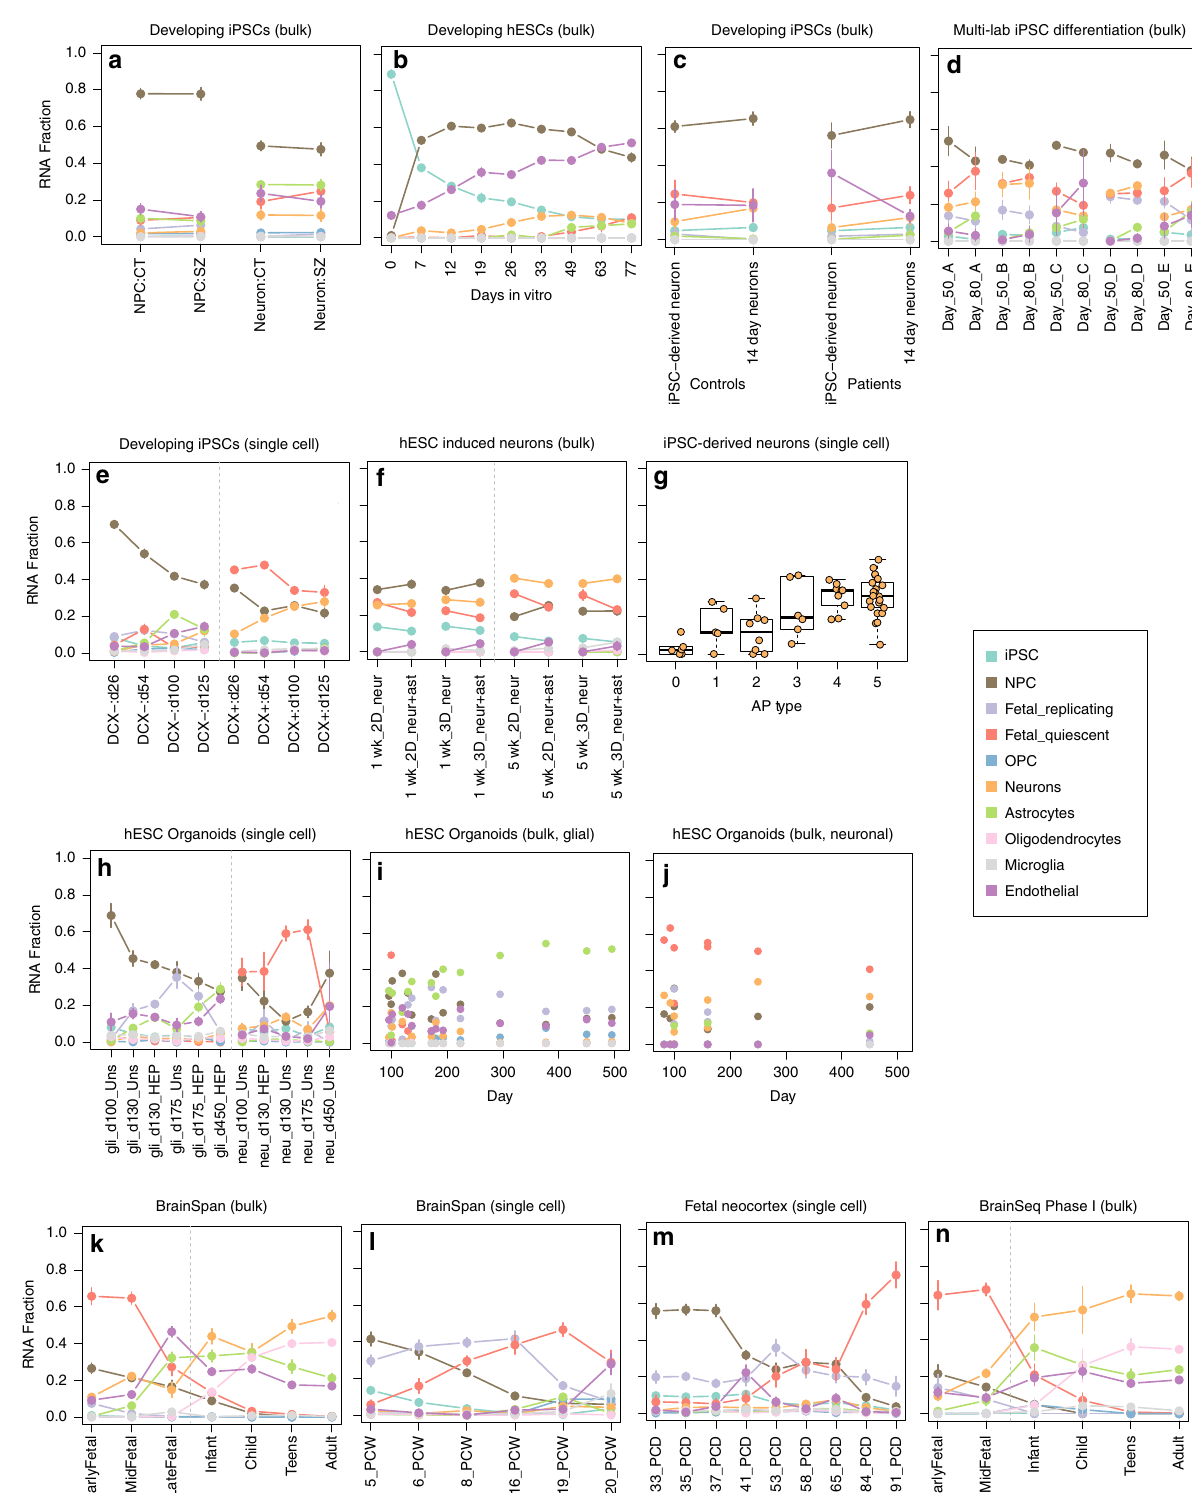
Fig. 6 Deconvoluting RNA fractions from publicly available RNA-seq data. We assessed the robustness of our deconvolution algorithm by applying it to various public RNA-seq datasets, including several bulk and single-cell iPSC-derived neuronal (a – g ) and organoid ( h – j ) datasets, which included assessing neuronal fractions in a multi-lab study ( d ) and in a Patch-seq dataset with paired electrophysiology data ( g ). We further applied the deconvolution algorithm to multiple studies of human brain tissue ( k – n ) comprising fetal through adult samples. Dots represent the mean proportions, while the vertical ticks show standard